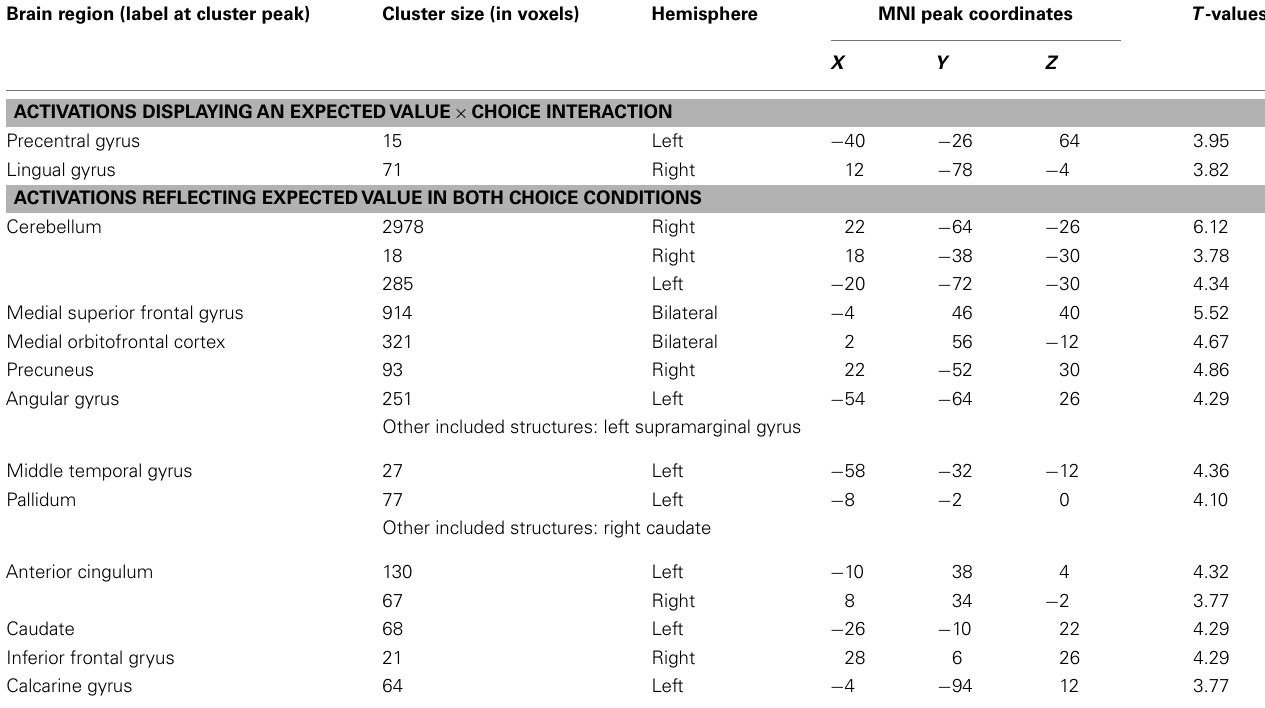
TableA6 | Neural correlates of expected value during selection (GLM3, whole-brain analysis, P < 0.001, k = 10). Brain region (label at cluster